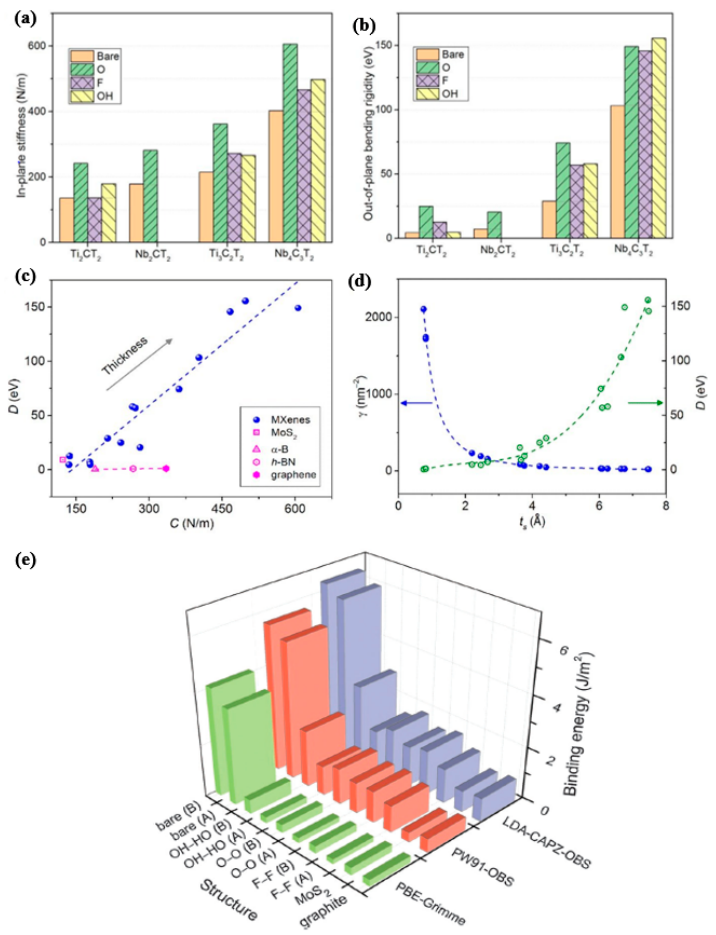
Figure 8. ( a ) In-plane stiffness and ( b ) out-of-plane bending rigidity MXenes. ( c ) Rigidity “D” vs. stiffness, ( d ) D vs. thickness t s . Reproduced with permission from [ 61 ] . Copyright RSC, 2020. ( e ) Comparison of the theoretical binding energies of Ti 3 C 2 T 2 , T = OH, F, and O relative to different 2D materials. Reproduced with permission from [ 65 ] . Copyright RSC, 2016.